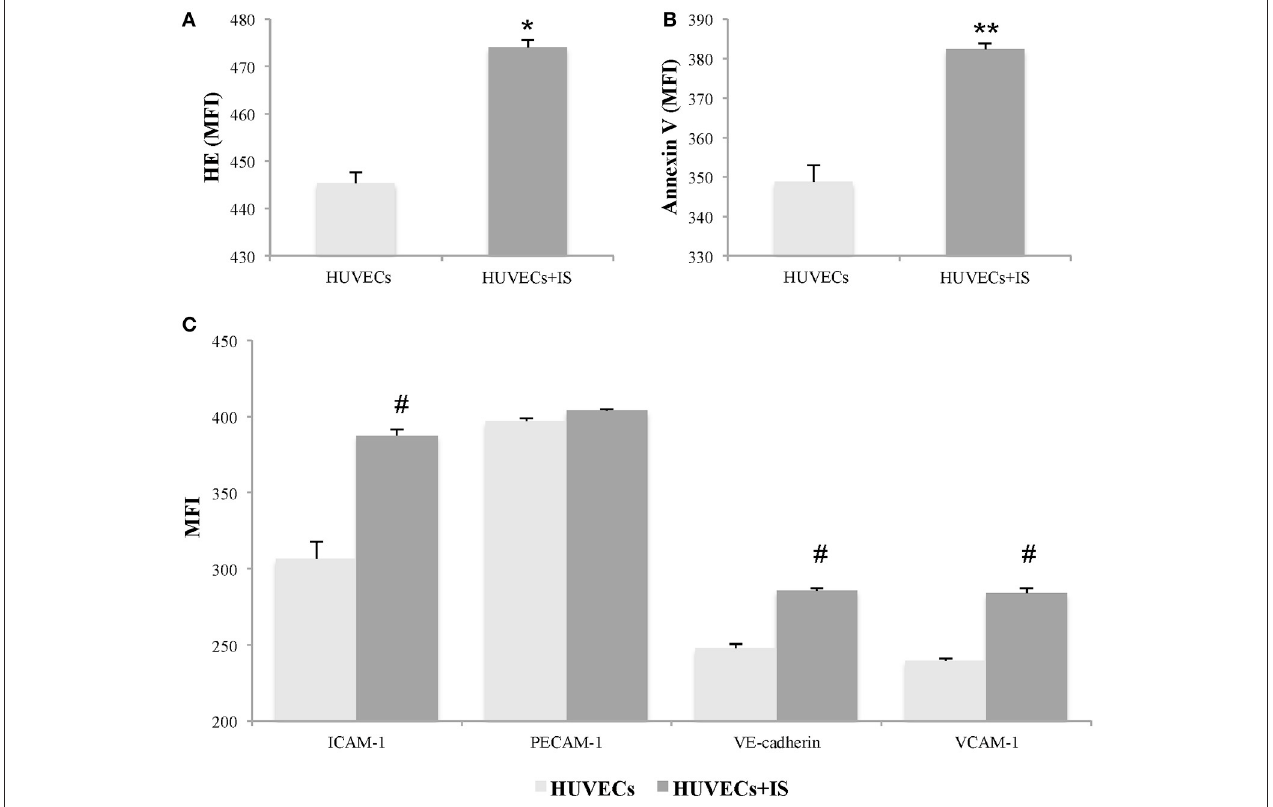
FIGURE 1 | Indoxyl sulfate (IS) induces activation in human umbilical vein endothelial cells (HUVECs). HUVECs treated with IS (256 µ g/ml) for 24 h showed significant increases in markers of oxidative stress and apoptosis. The expression was quantified by changes in the mean fluorescent intensity (MFI) of (A) hydroethidine (HE) and (B) annexin V. In addition, (C) IS induced significantly elevated expression of ICAM-1, VE-cadherin, and VCAM-1, but not PECAM-1. Data are the means ± SEM of five independent experiments. * p = 0.004 vs. untreated HUVECs; ** p = 0.045 vs. untreated HUVECs; and # p ≤ 0.001 vs. untreated HUVECs.